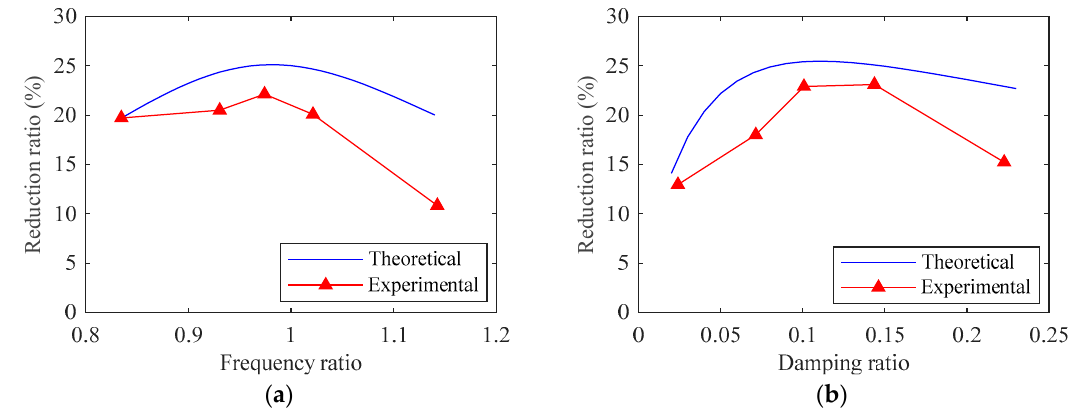
Figure 24. Reduction ratios in along-wind direction under wind speed of 24.7 m/s and wind direction angle of 0°. ( a ) Variation of reduction ratio with frequency ratio; ( b ) Variation of reduction ratio with damping ratio of ECTMD. Table 6. Dynamic responses in case of wind speed of 24.7m / s and wind direction angle of 0 ◦ . RMS Acceleration Reduction Ratio (%) Wind Speed Without ECTMD With ECTMD (m / s) Theoretical Experimental Theoretical Experimental Theoretical